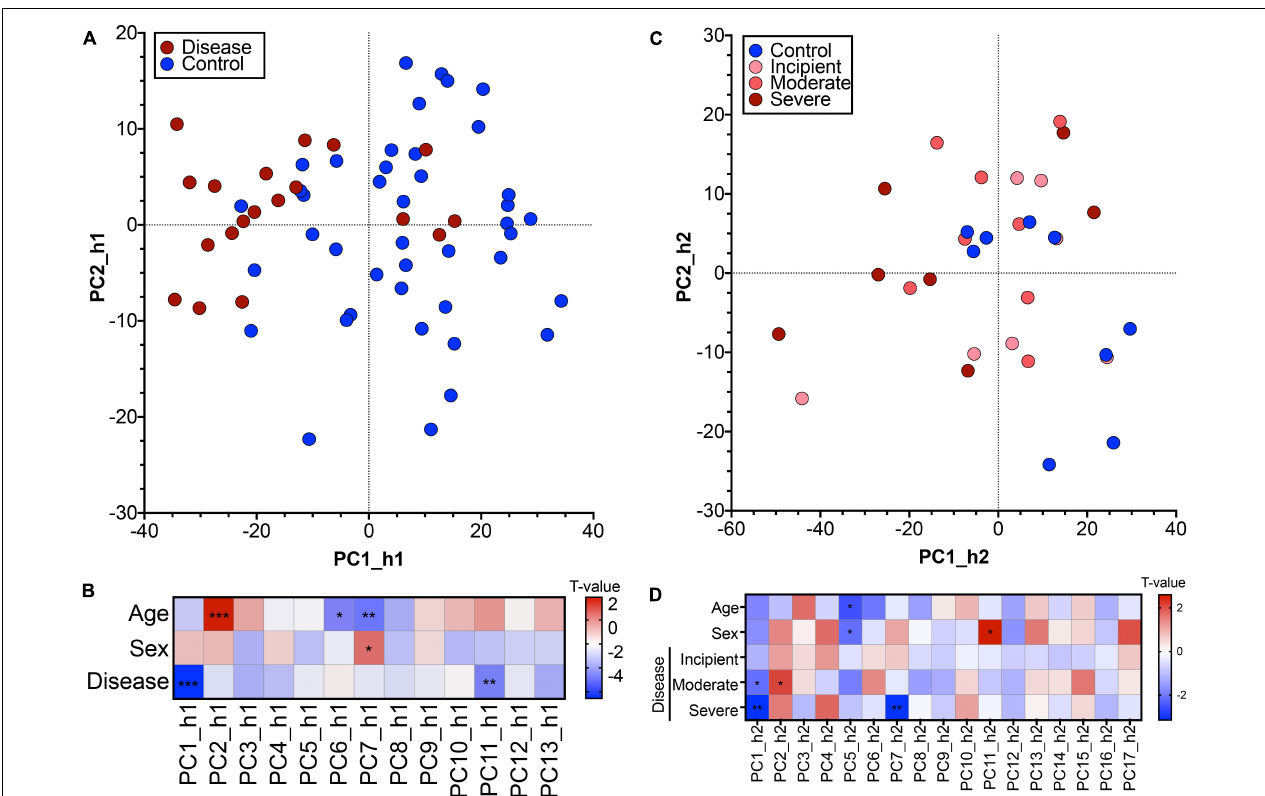
FIGURE 2 | Postmortem hippocampal brain tissue transcriptomics used to generate human Principal Component Analysis models. (A) Principal component biplot showing 62 hippocampal human samples (GSE48350, human cohort 1) in PC1_h1, PC2_h1 space. The original, feature-level input to the PCA was genes differentially expressed between control (blue) and disease (red) patients at a permissive threshold of Benjamini-Hochberg adjusted p -value < 0.20 with no fold change criteria. (B) Linear regression relating human sample scores along each human PC with age, sex, and disease reported for human cohort 1 identified PCs associated with patient outcomes. A positive t -value indicates association with higher numerical age and males for the age and sex categories, respectively. (C) Principal component biplot showing 31 hippocampal human samples (GSE1297, human cohort 2) in PC1_h2, PC2_h2 space. The original, feature-level input to the PCA was all genes with human-to-mouse homologs. (D) Linear regression relating human sample scores along each human PC with age, sex, and disease reported for human cohort 2 identified PCs associated with patient outcomes. A positive t -value indicates association with higher numerical age and males for the age and sex categories, respectively. * < 0.05, ** < 0.01, *** <